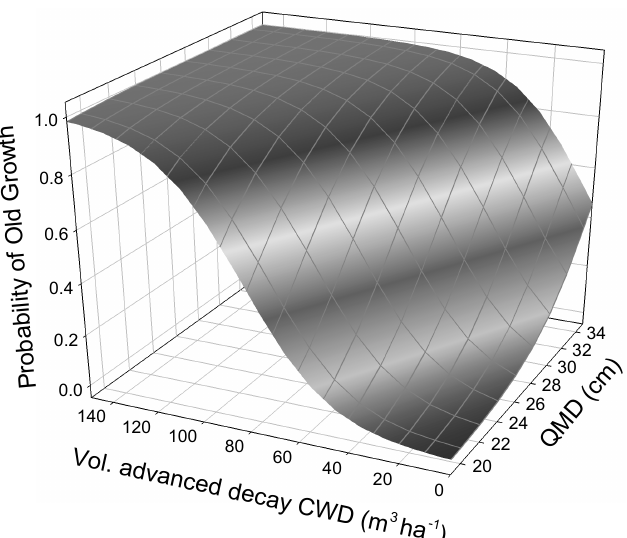
Figure 2. Probability of old-growth white-cedar as a function of volume of advanced-decay coarse